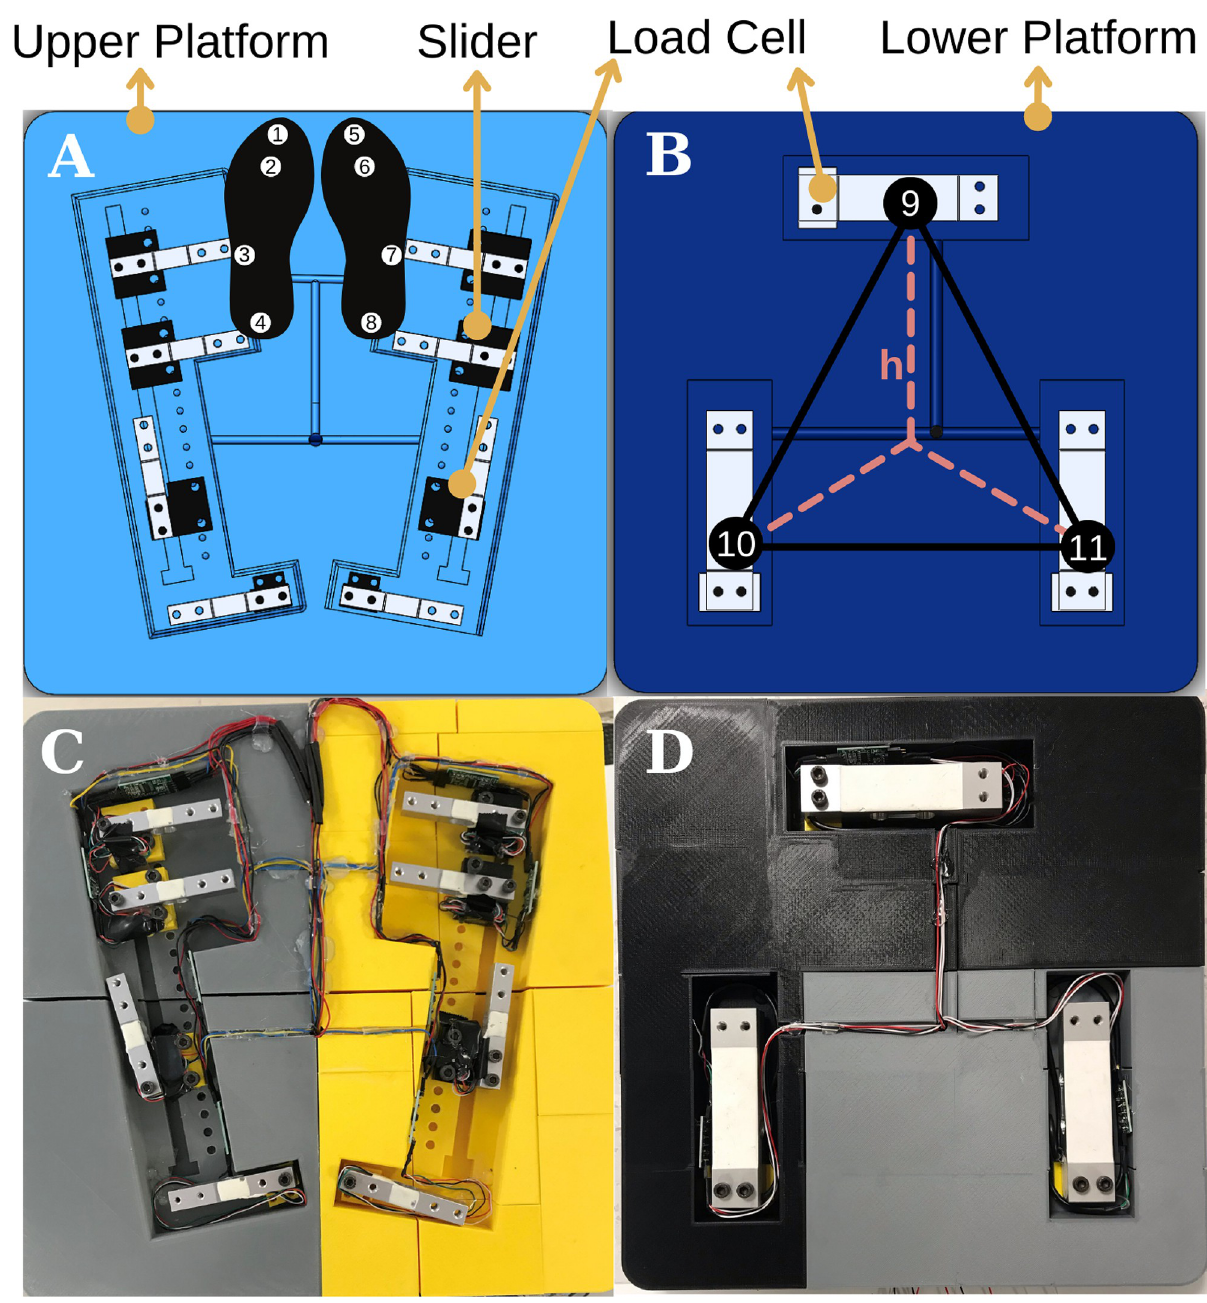
Fig 3. Upper and lower platforms (A) In the solid model, the components and their positioning on the upper platform are demonstrated (B) In the solid model, the components and their positioning on the lower platform are demonstrated (C) Top view of the prototype of the upper platform (D) Top view of the prototype of the lower